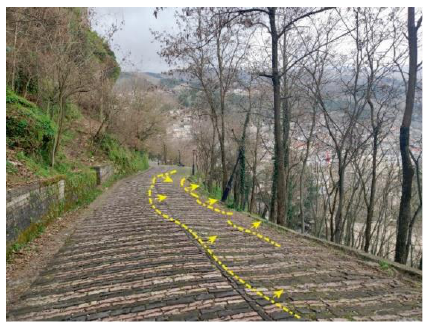
Figure 6. Scarps along the road on the northwest part of the castle. The retaining wall, as well as the lamppost, are rotated and have sunk with respect to the road. In yellow, dotted lines marking shape and direction of deformation on perimetral road below the castle.